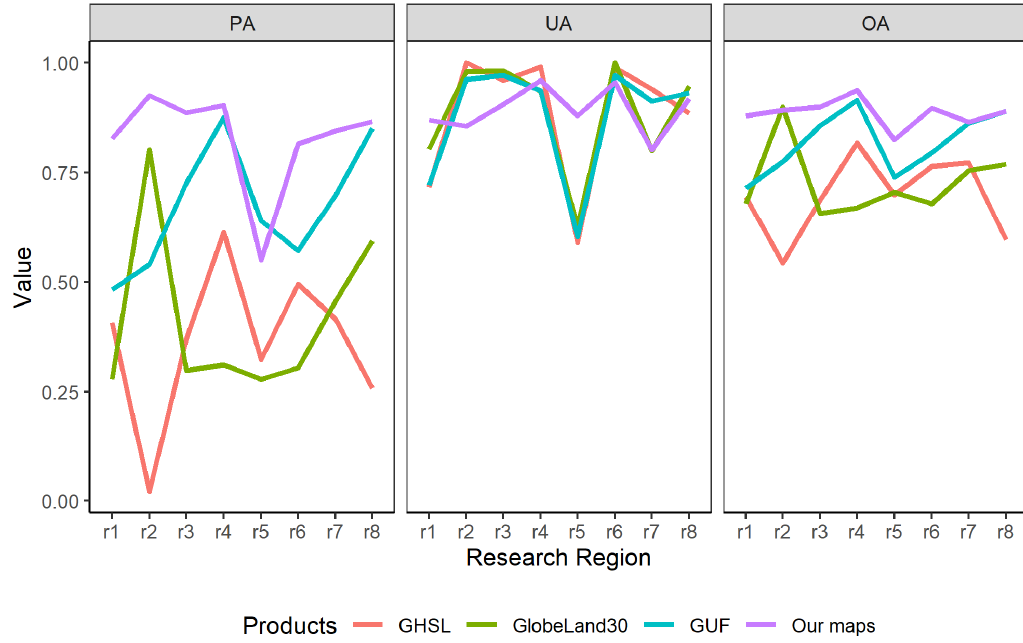
Figure 9. Producer’s accuracy, user’s accuracy and overall accuracy for our and current mainstream products for eight research regions (r1–r8 represent eight selected regions).